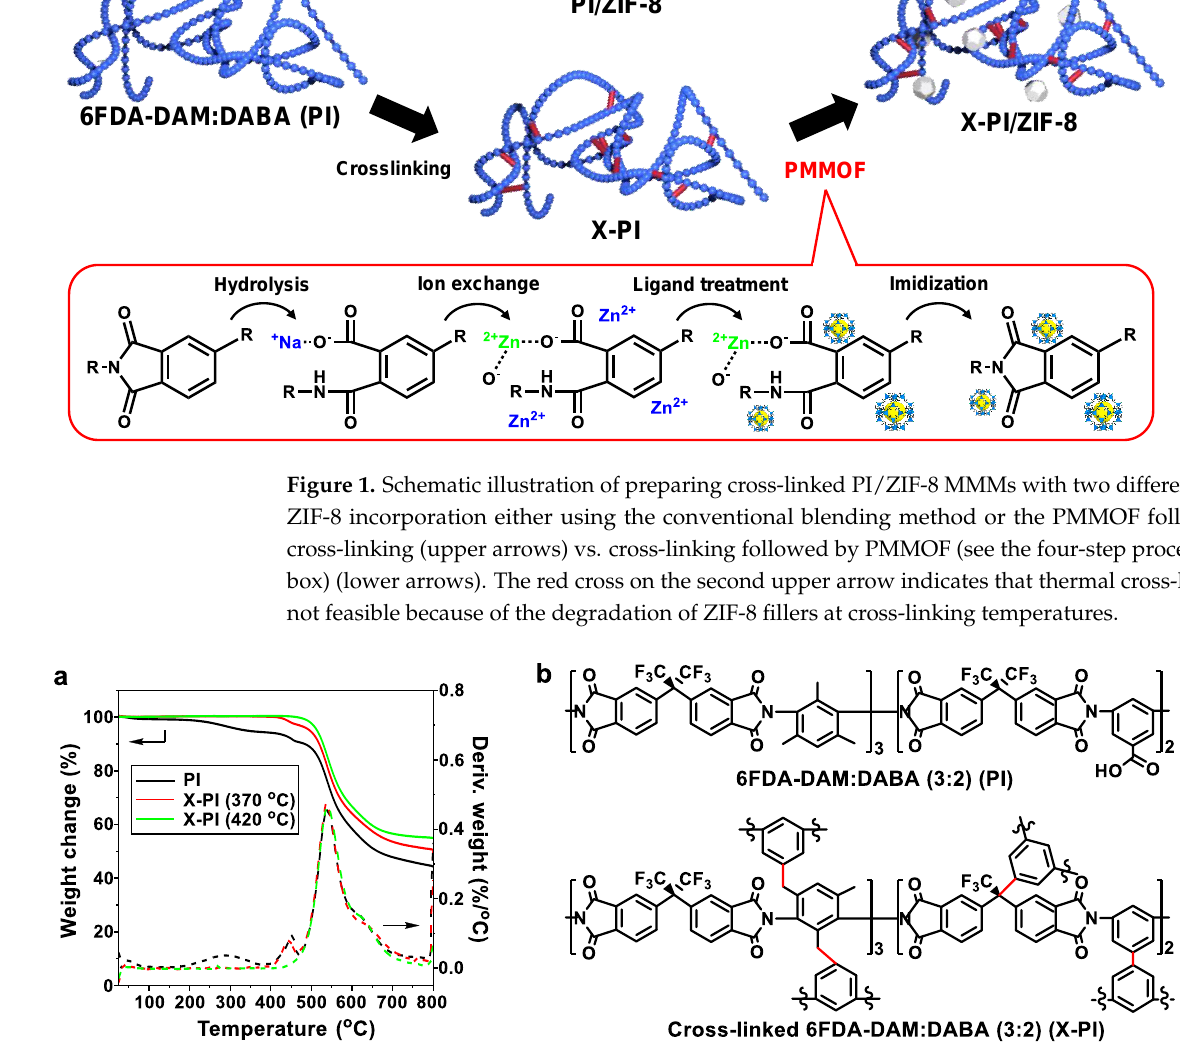
Figure 1. Schematic illustration of preparing cross-linked PI/ZIF-8 MMMs with two different routes: ZIF-8 incorporation either using the conventional blending method or the PMMOF followed by cross-linking (upper arrows) vs. cross-linking followed by PMMOF (see the four-step process in red box) (lower arrows). The red cross on the second upper arrow indicates that thermal cross-linking is not feasible because of the degradation of ZIF-8 fillers at cross-linking temperatures.